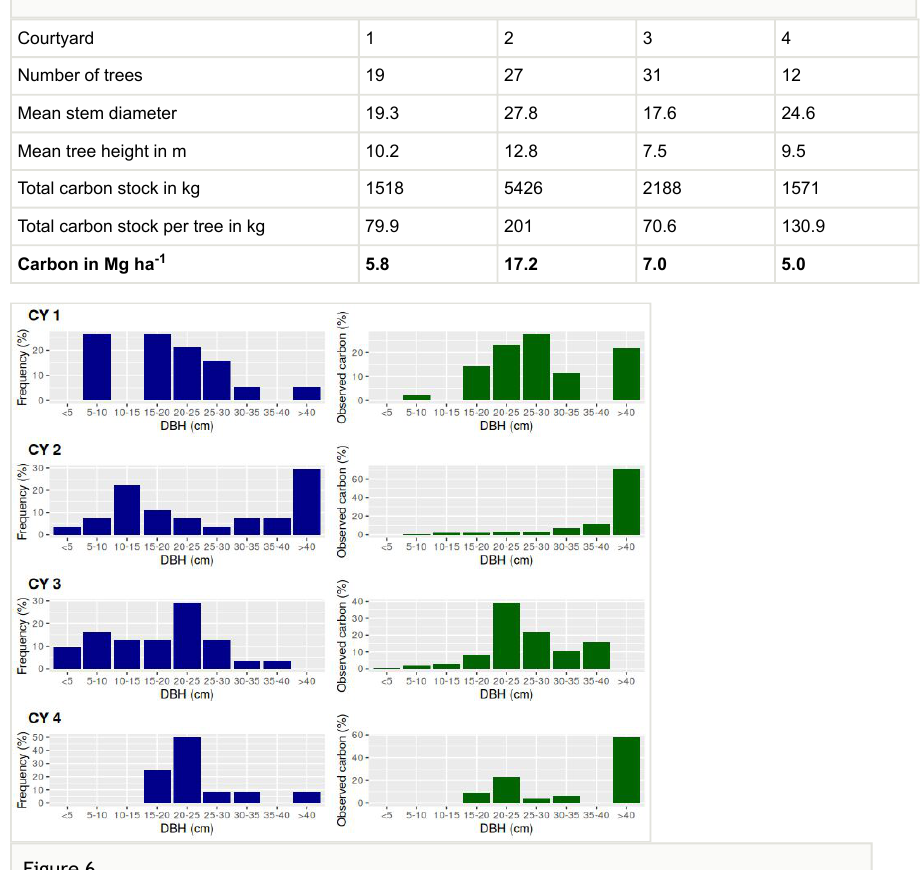
Results of the assessment of carbon stocks, based on allometric equations after Chojnacky et al. (2014).